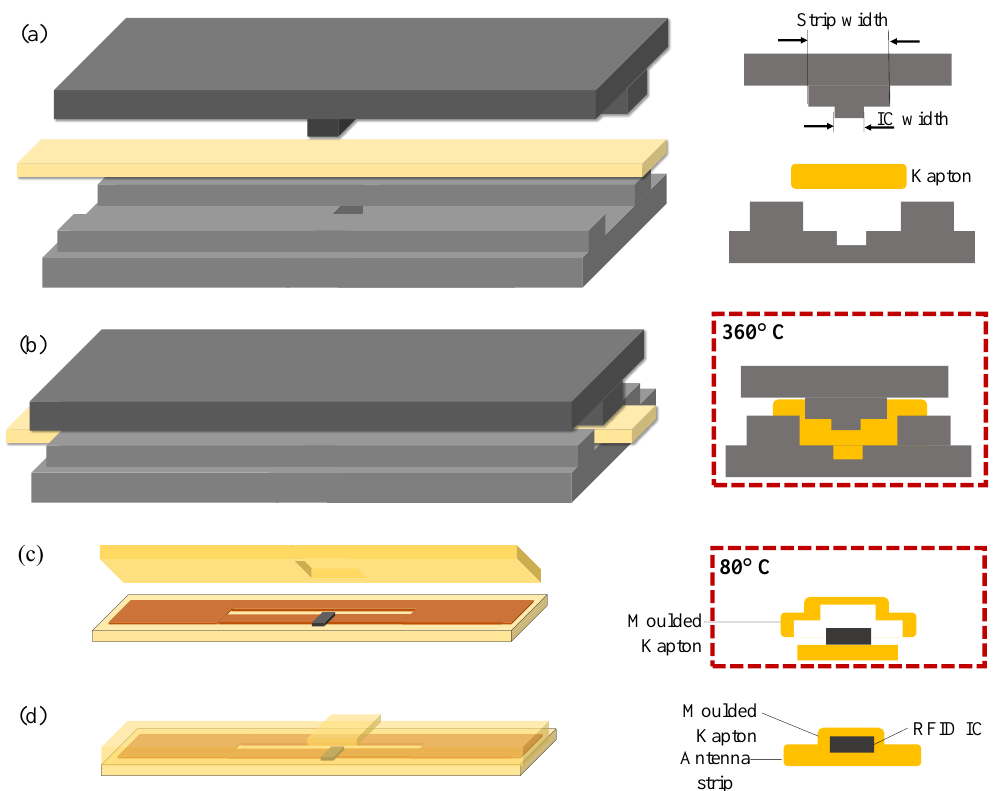
Figure 4. The proposed encapsulation technique of the RFID tag: ( a ) The bespoke Kapton molding tool, ( b ) molding the Kapton at 360 ◦ C, ( c ) the molded Kapton sandwich fitting onto the RFID filament, ( d ) the encapsulated RFID strip.